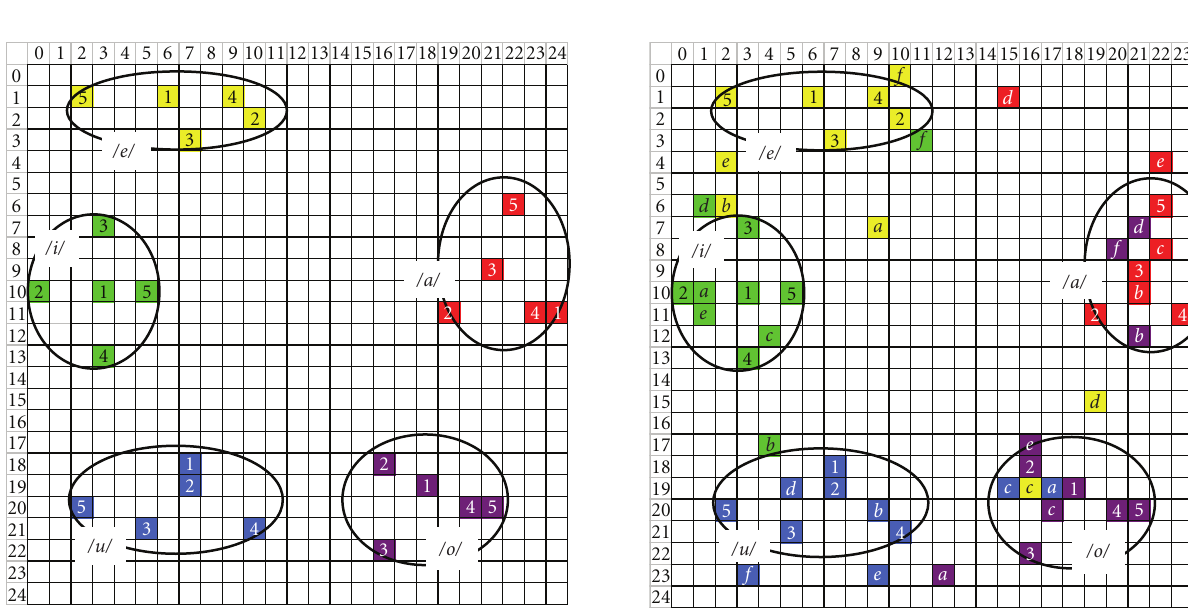
Figure 4: Mapping results of six di ff erent voices given by hearing- impaired speakers no.